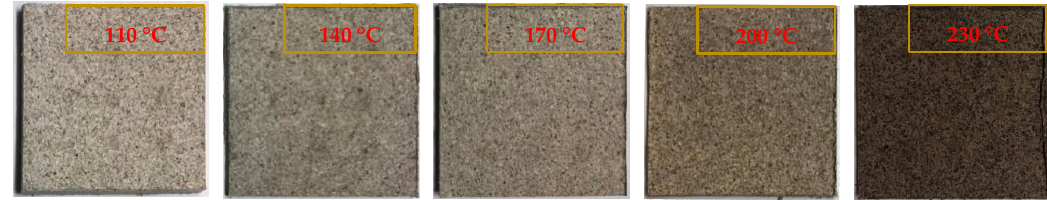
ff erent heating